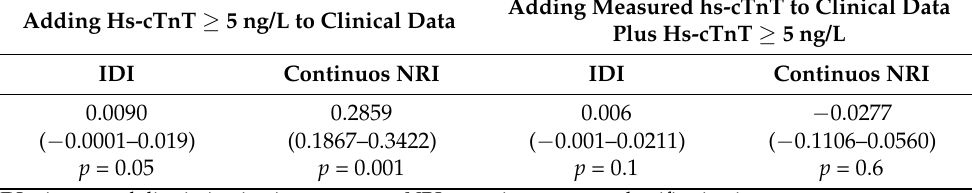
Table 4. Risk reclassification for the primary endpoint after combining hs-cTnT and clinical data. Adding Hs-cTnT ≥ 5 ng/L to Clinical Data